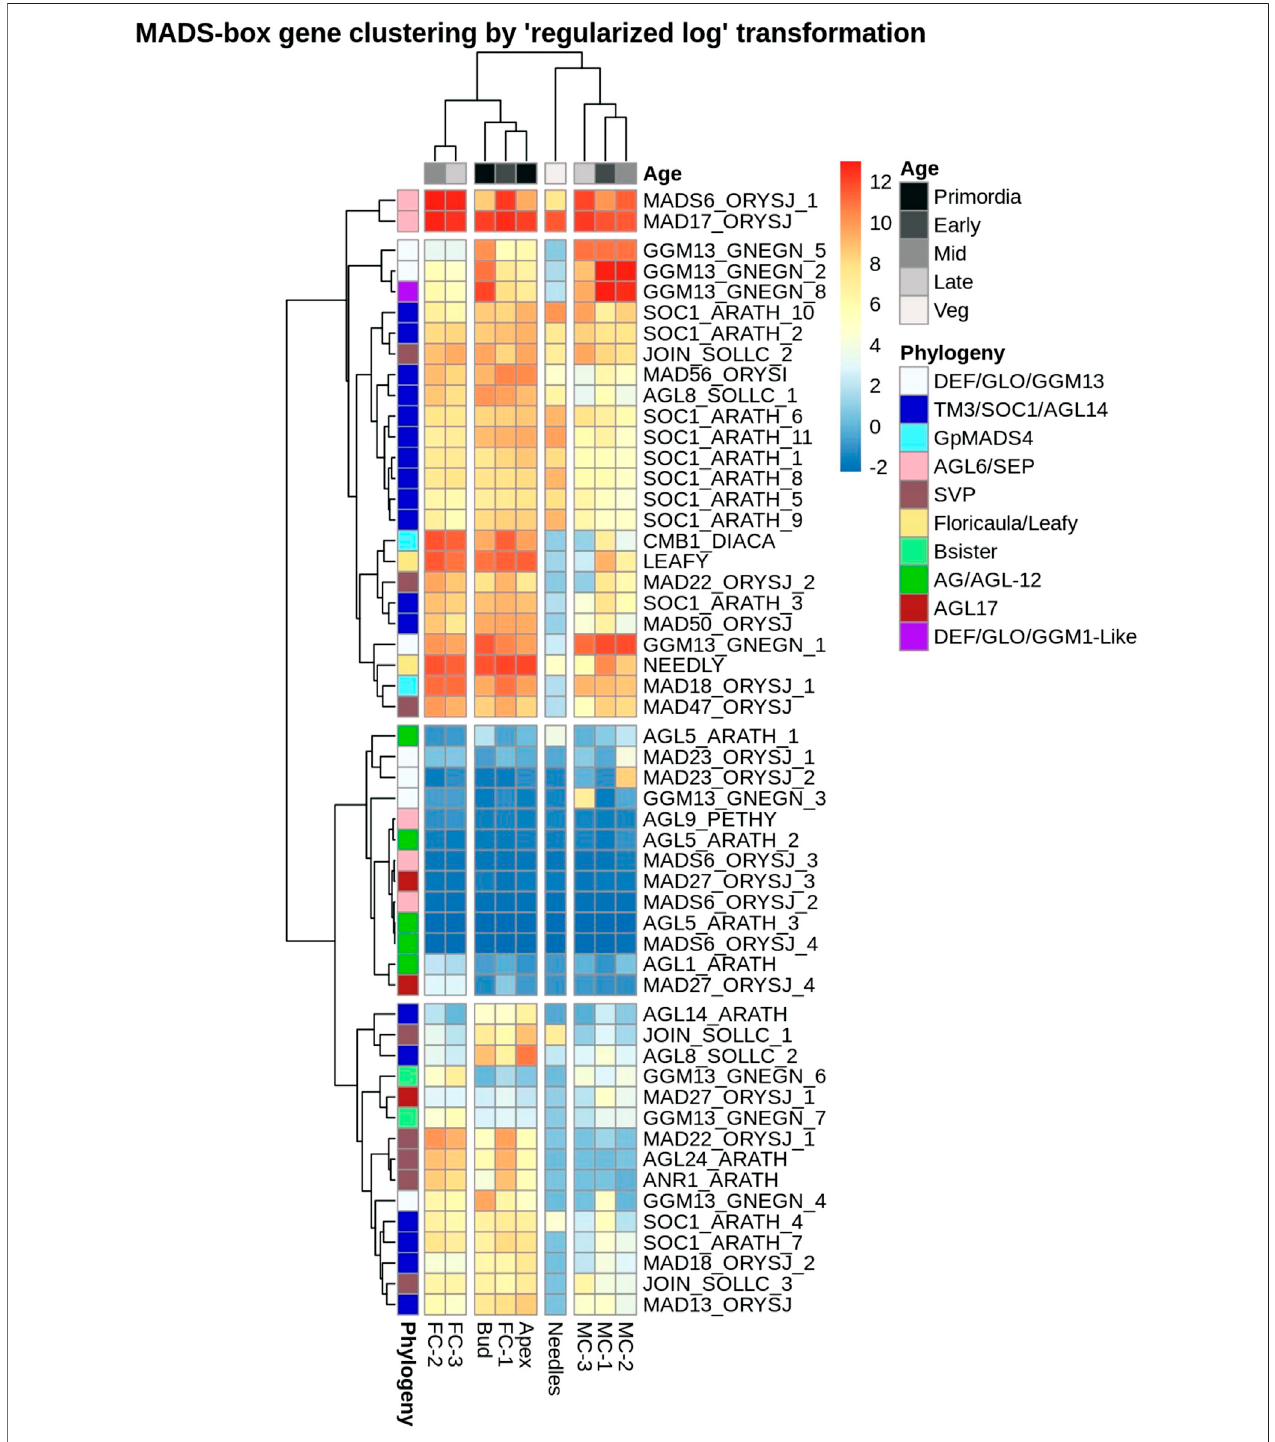
FIGURE6| Heatmap showingexpression levelsof P.densi fl ora MADS-box typeIIgeneshierarchicallyclusteredbasedonrelation totime-pointsandtissue types. Rows correspond to the 54 MADS box genes (names abbreviated to the closed angiosperm ortholog) and columns correspond to the nine tissue types. A relative decrease in expression (normalized counts) is indicated in blue while increases are red. Here, “ Veg ” is related to needles sampled regardless of stage. Genes with less than three counts in each independent dataset were omitted in this analysis.